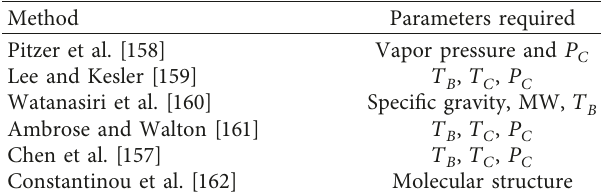
Table 21: Methods for the estimation of the acentric